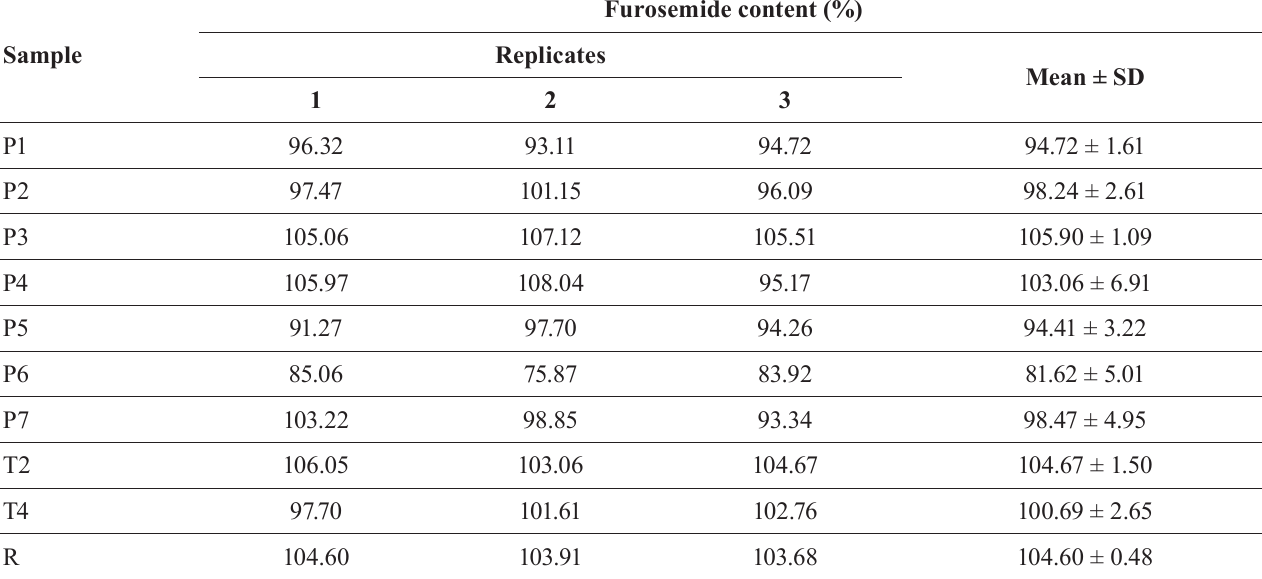
TABLE IV - Furosemide content as a mean percentage of label’s claim for compounded batches (P1 to P7), batches made in- house (T2 and T4) and batch of the reference medicinal product